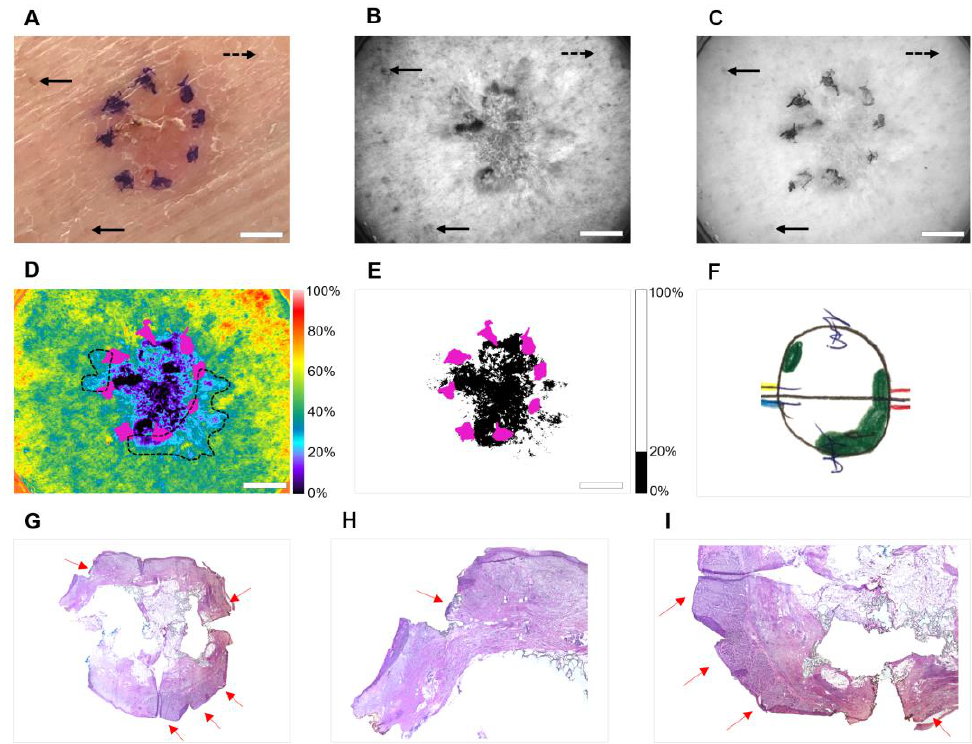
Figure 2. Example case with positive surgical margins (subject #9). ( A ) Preoperative photograph of BCC lesion outlined with surgical marker; ( B ) 440 nm cross-polarized image; ( C ) 640 nm cross-polarized image; ( D ) Pseudo-colored, spectrally encoded image overlaid with surgical marker (shown in magenta). Positive margins have been outlined in dashed black lines. ( E ) Binary, spectrally encoded image overlaid with surgical marker (threshold = 20%); ( F ) Intraoperative Mohs map (positive margins are drawn in green); ( G ) H&E histology; ( H ) Magnified view of positive surgical margin (10:00 o’clock position) in histology section; ( I ) Magnified view of positive surgical margin (3:00–6:00 o’clock position) in histology section (rotated 90°). The color bars in ( D ) and ( E ) show pixel values as a percentage of the maximum pixel value in the image. Solid black arrow: pigmentation spot; dashed black arrow: blood vessel; solid red arrow: residual tumor at lateral boundary of H&E section. Scale Bar = 5 mm.